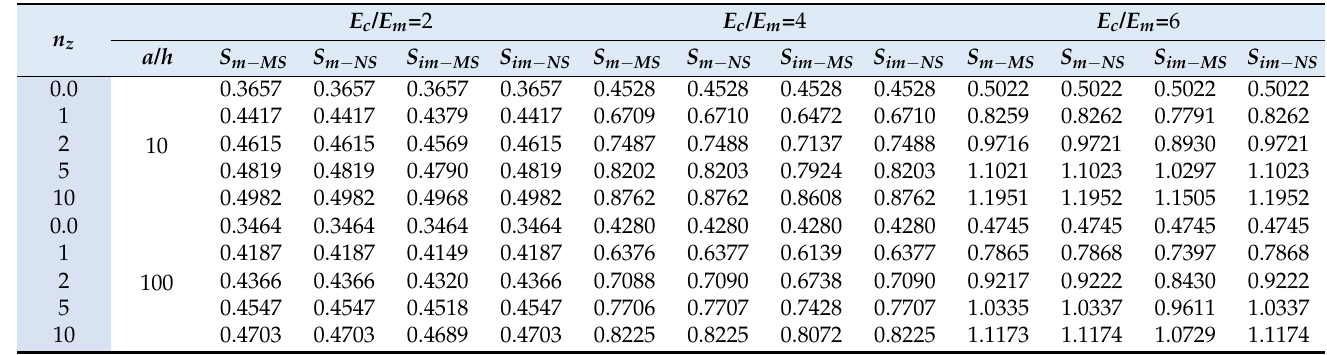
Table 4. Influence of Young’s modulus ratio ( E c / E m ) on the non-dimensional maximum deflection (cid:16) w = w